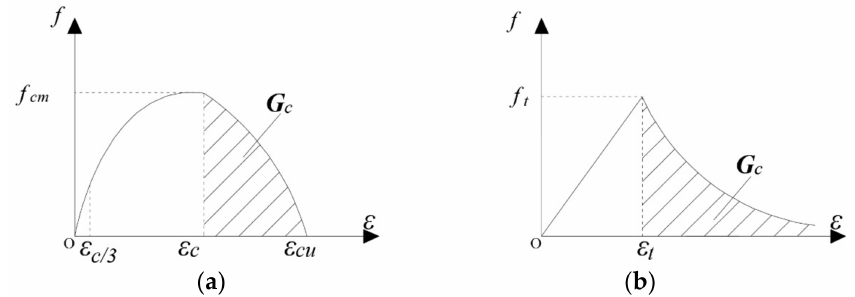
Figure 2. Material constitutive law: of masonry in ( a ) compression and ( b )